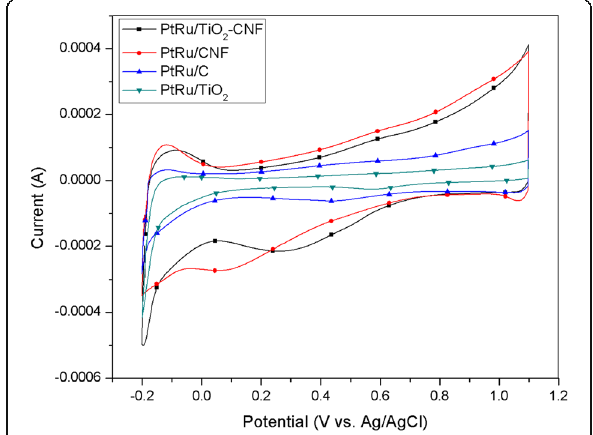
Fig. 3 Cyclic voltammetry profiles of the different catalyst supports, PtRu/TiO 2 -CNF, PtRu/CNF, PtRu/C, and PtRu/TiO 2 in 0.5 M H 2 SO 4 solution at the scan rate of 20 mV s − 1